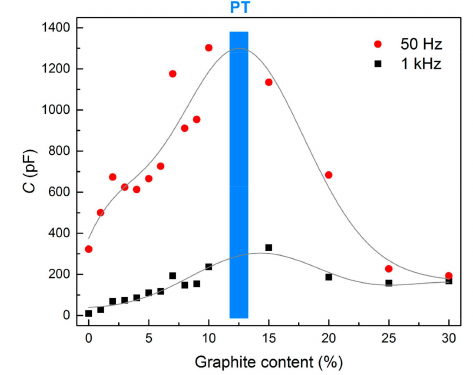
Figure 9. Change in the electrical capacitance of AAS composites with respect to graphite content at 50 Hz and 1 kHz (PT = percolation